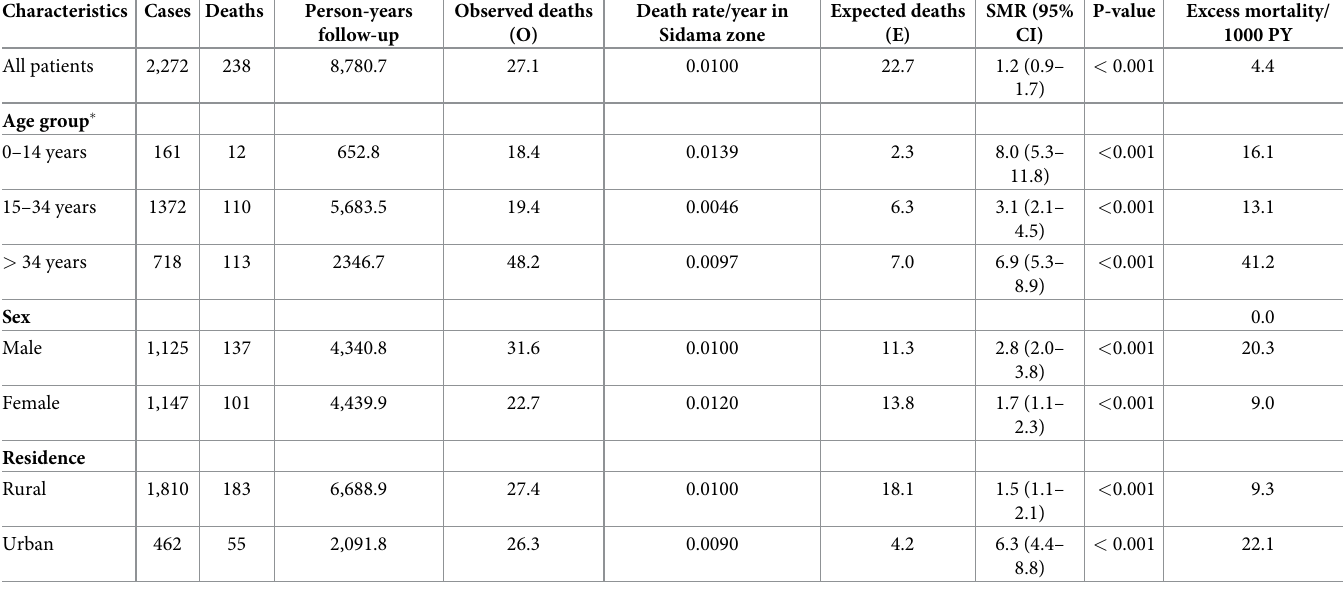
Table 4. Excess mortality among the TB patients in Dale district, South Ethiopia. Characteristics Cases